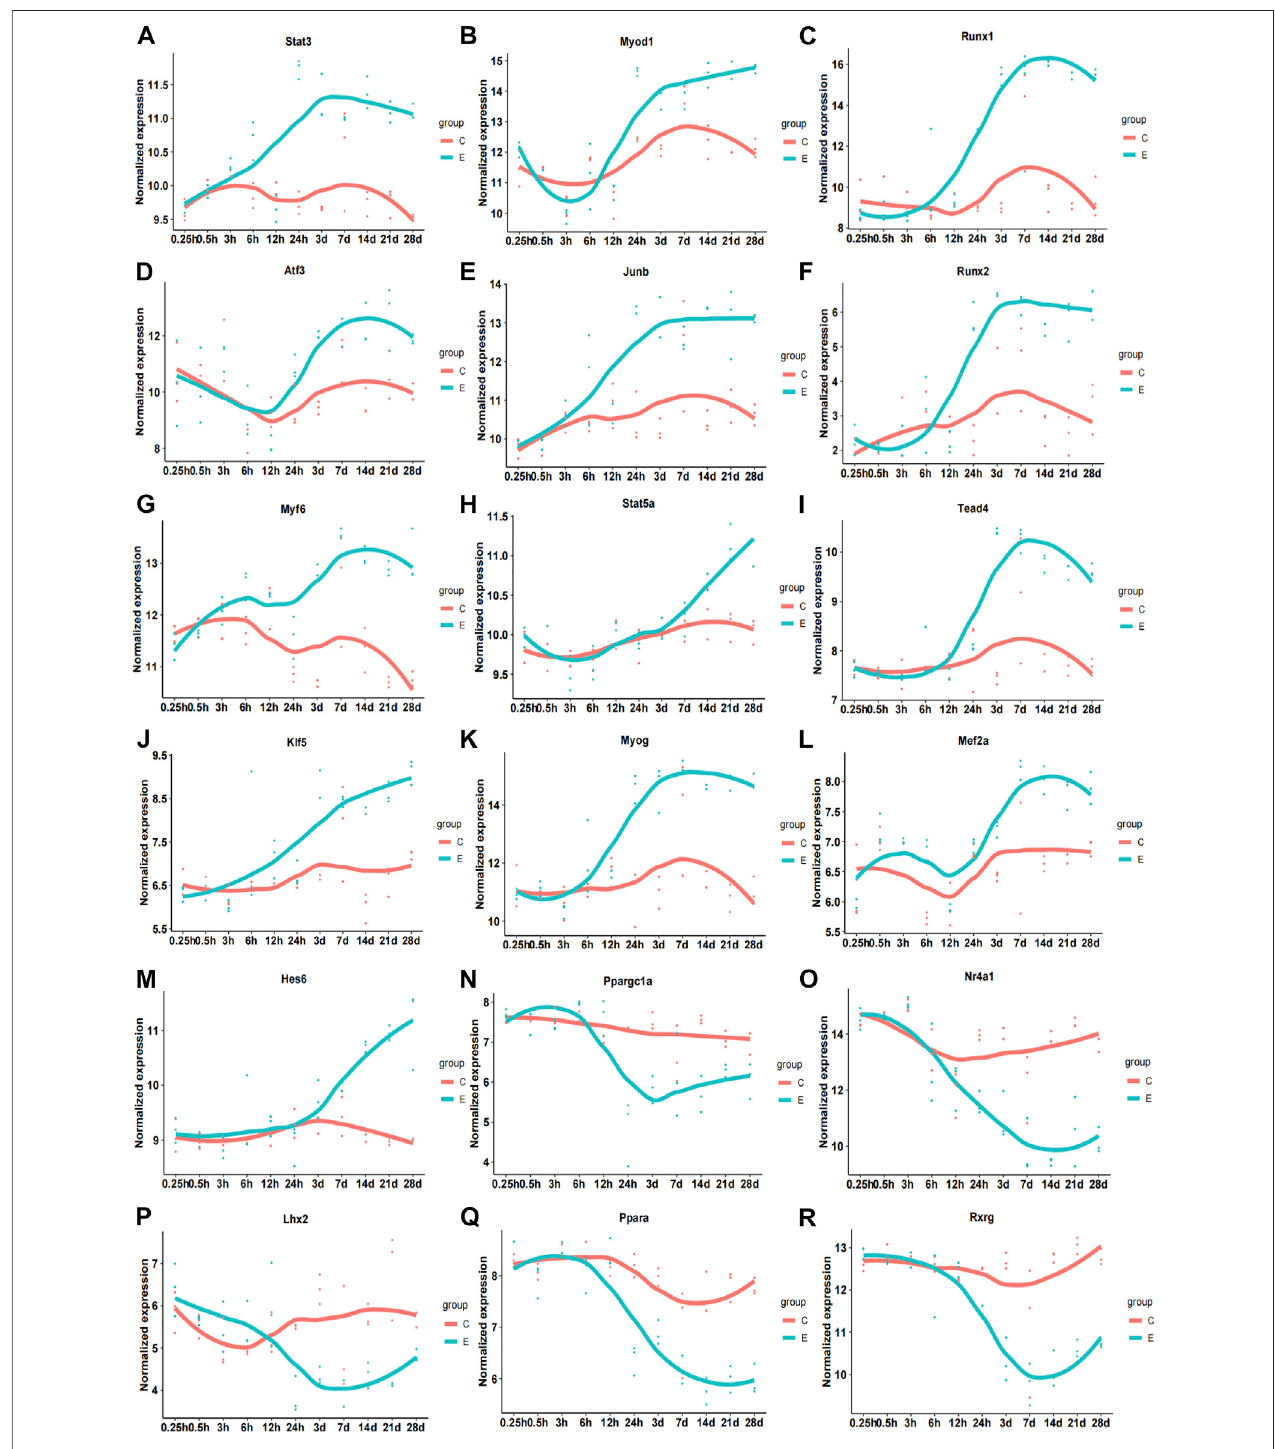
FIGURE 6 | Time-dependent expression of differentially expressed genes of 18 transcription factors related to pathophysiology of skeletal muscle. (A) Stat3. (B) Myod1. (C) Runx1. (D) Atf3. (E) Junb. (F) Runx2. (G) Myf6. (H) Stat5b. (I) Tead4. (J) Klf5. (K) Myog. (L) Mef2a. (M) Hes6. (N) Ppargc1a. (O) Nr4a1. (P) Lhx2. (Q) Ppara. (R) Rxrg. C, sham group; E, denervation group.